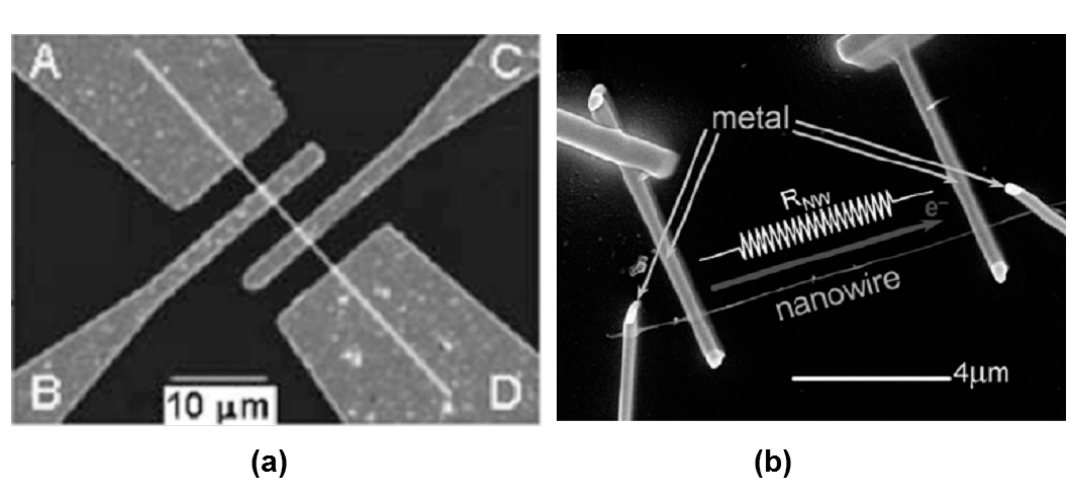
Figure 4. SEM images of gas sensors based on single metal oxide nanobelts and nanowires. ( a ) Reprinted with permission from Fields et al. [148]. Copyright 2006: American Institute of Physics. ( b ) Reproduced with permission from Hernandez-Ramirez et al. [149]. Copyright 2009: Royal Society of